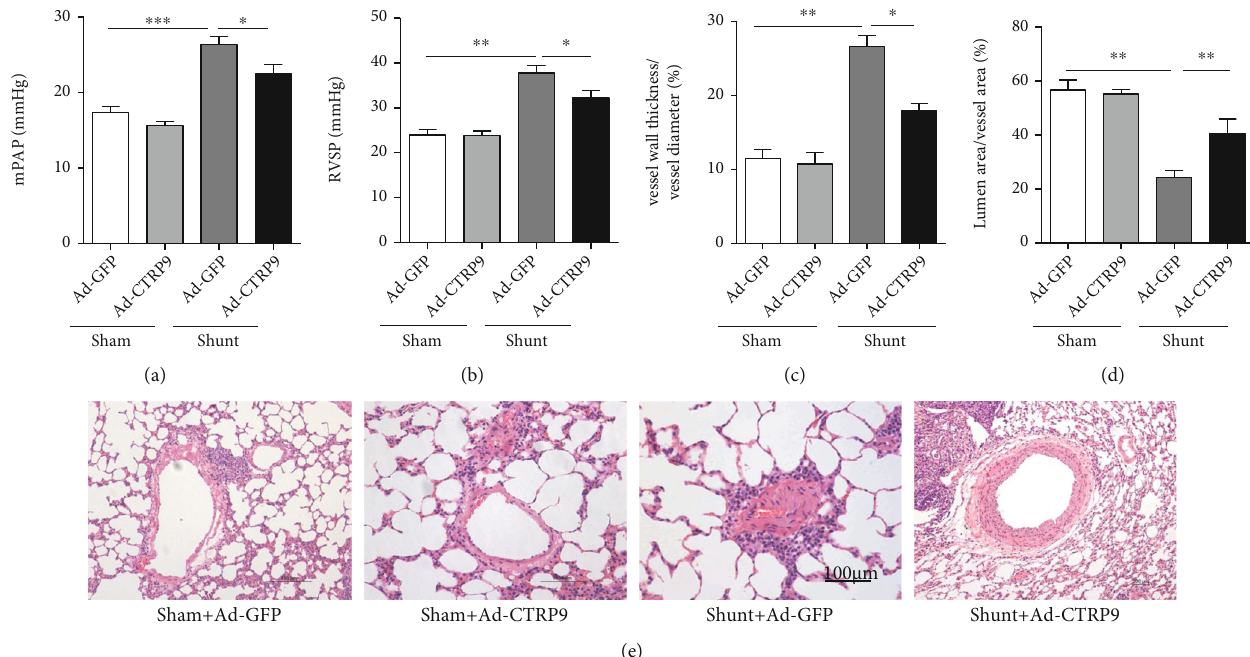
Figure 2: PAH is prevented and attenuated by the administration of CTRP9. (a) The rats in the shunt group exhibited a signi fi cantly higher mPAP compared with that of the rats in the sham group at the end of the 12 th week. (b) The rats in the shunt group exhibited a signi fi cantly higher RVSP compared with that of the rats in the sham group at the end of the 12 th week. (c) Quanti fi cation of the percentage of wall thickness to vessel diameter. (d) Quanti fi cation of the lumen area to vessel total area. (e) Representative images of H&E-stained resistant pulmonary arteries from the di ff erent experimental groups. n = 10 of each group. Mean ± SEM . ∗ P < 0 : 05 and ∗∗ P < 0 : 01 vs. the Ad-GFP- sham group. PAH: pulmonary arterial hypertension; CTRP9: C1q/TNF-related protein 9; mPAP: mean pulmonary artery pressure; RVSP: right ventricular systolic pressure; H&E: hematoxylin and eosin; Ad-GFP: adenovirus-green fl uorescent